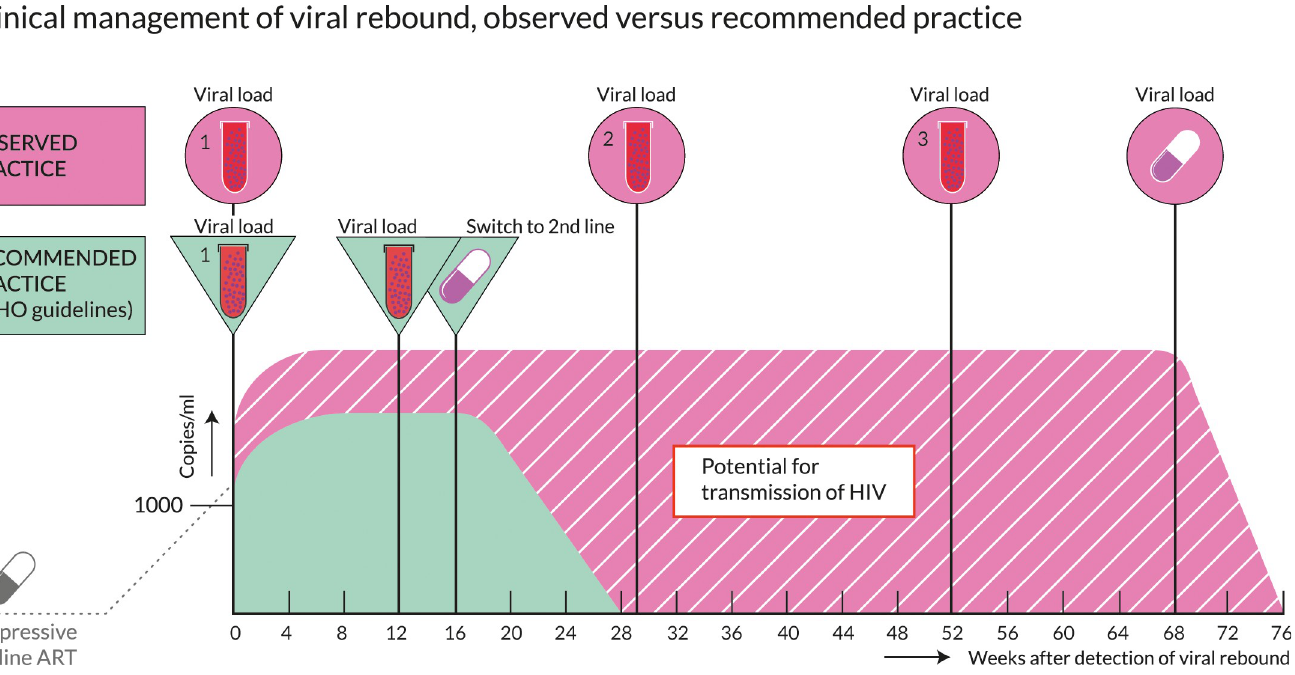
Fig 4. Clinical management of viremia—Observed versus recommended